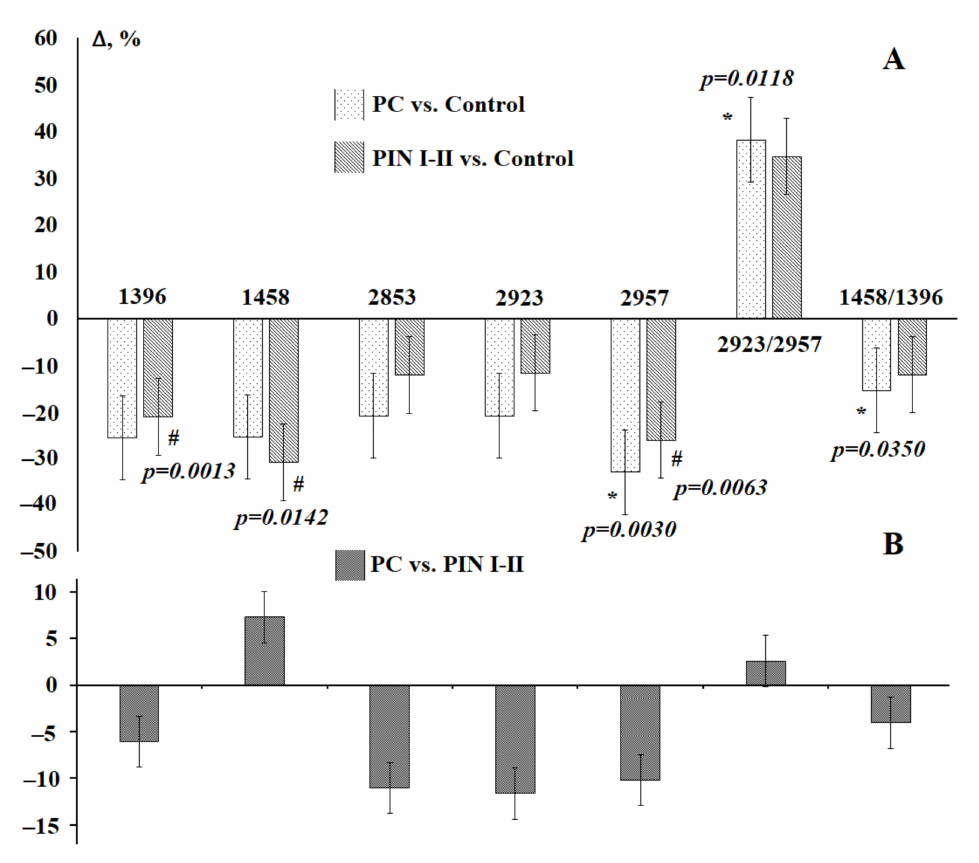
Figure 8. Changes in the intensity of the absorption bands of lipids in saliva with pathologies of the prostate gland: ( A )—compared with the control group, ( B )—compared with non-malignant pathologies. p -values are calculated using the paired Mann–Whitney test. */#—differences are statistically significant, p <